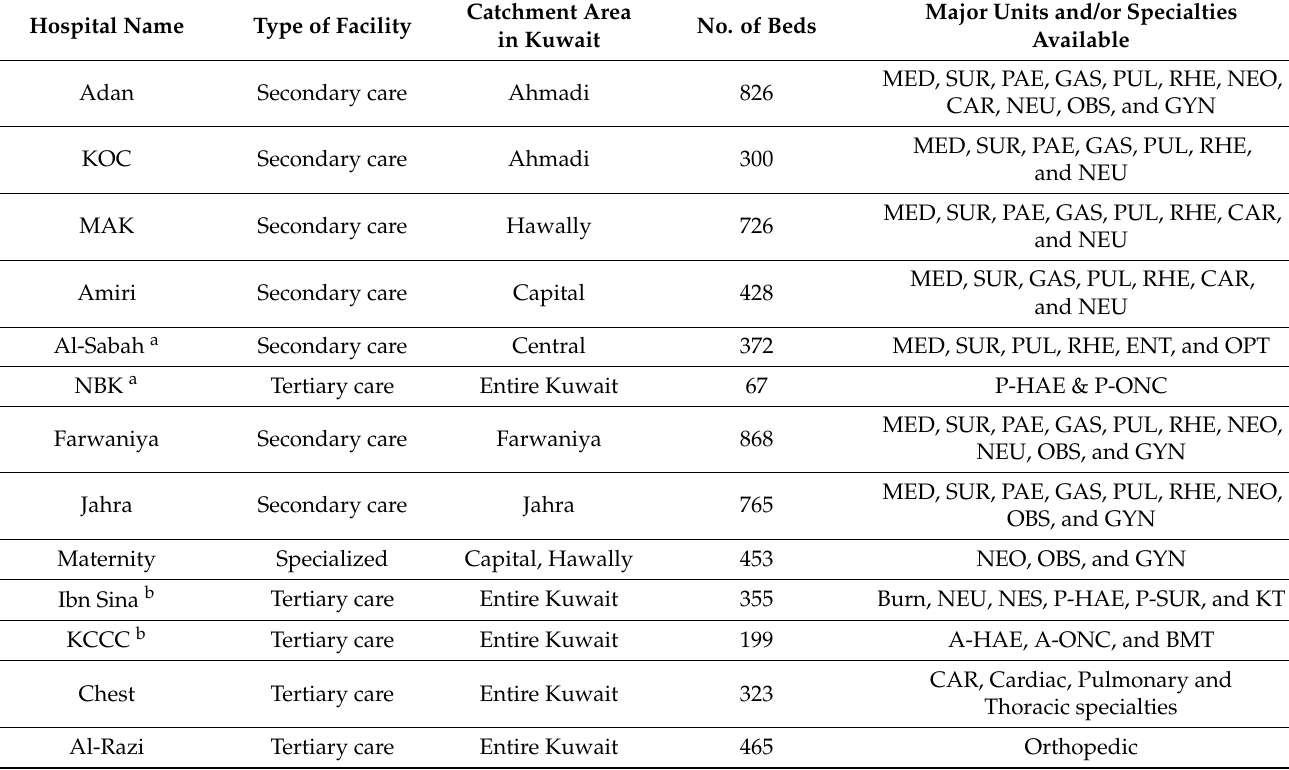
Table 1. Number of beds, catchment area, and units/specialties available in different hospitals in